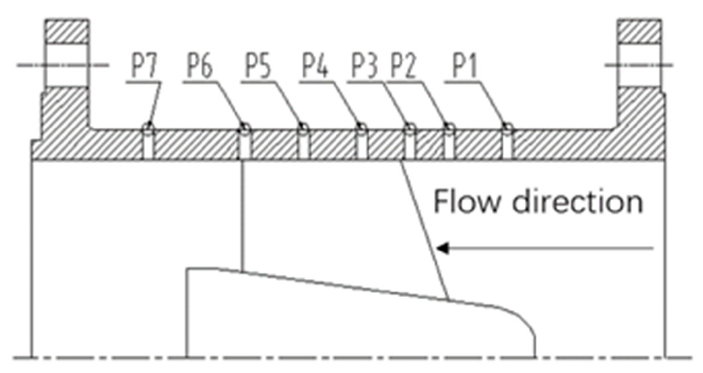
Figure 3. Schematic illustration of pressure monitors (P1 ‐ P7 are the measuring points).